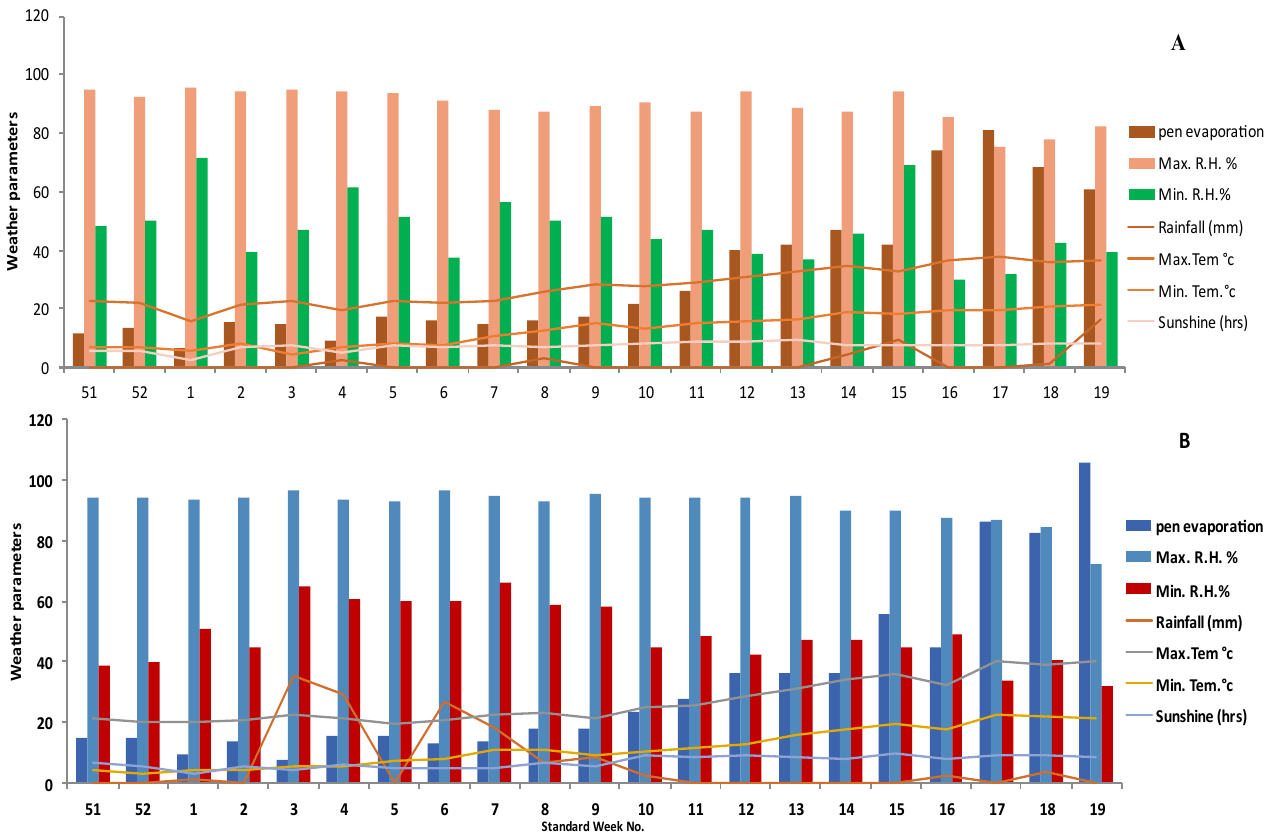
Figure 2. Weekly average meteorological conditions for crop growth ( A ) during 2017 – 2018 and ( B ) during 2018 – 2019 at experimental location.